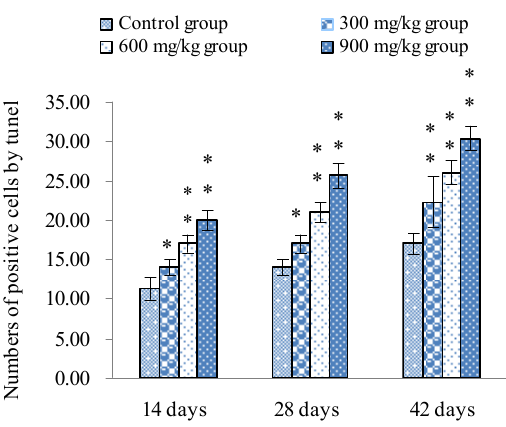
Figure 4. Numbers of positive cells by